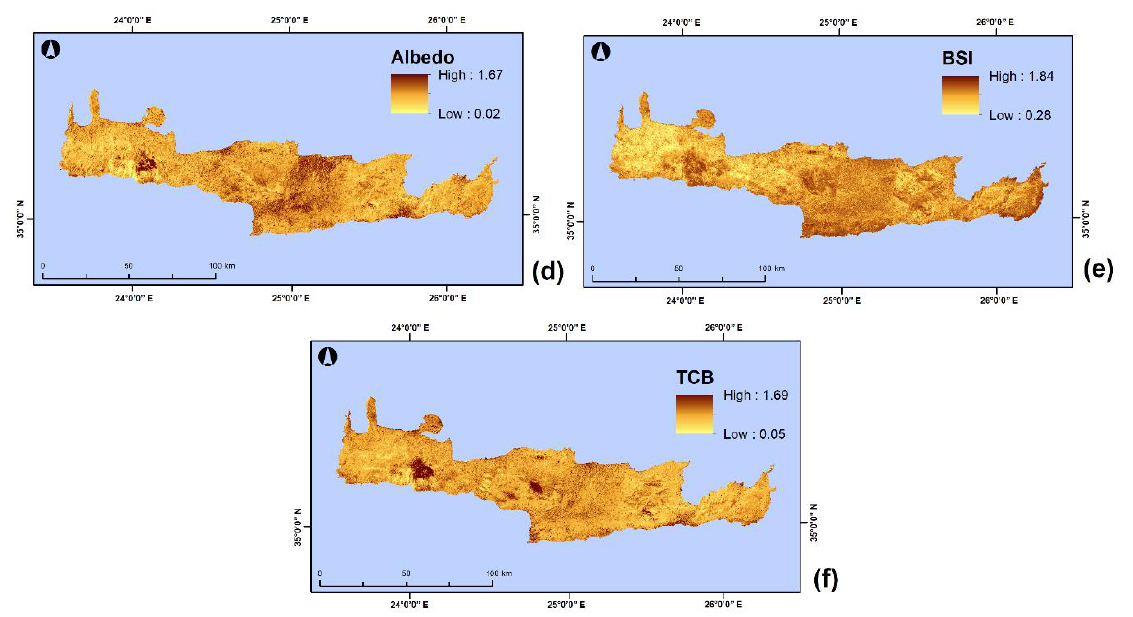
Figure 3. Spectral indices for selected dates: ( a ) normalized difference vegetation index (NDVI) for 1999; ( b ) soil adjusted vegetation index (SAVI) for 2009; ( c ) tasseled cap greenness (TCG) for 2019; ( d ) Albedo for 1999; ( e ) bare soil index (BSI) for 2009; ( f ) tasseled cap brightness (TCB) for 2019.